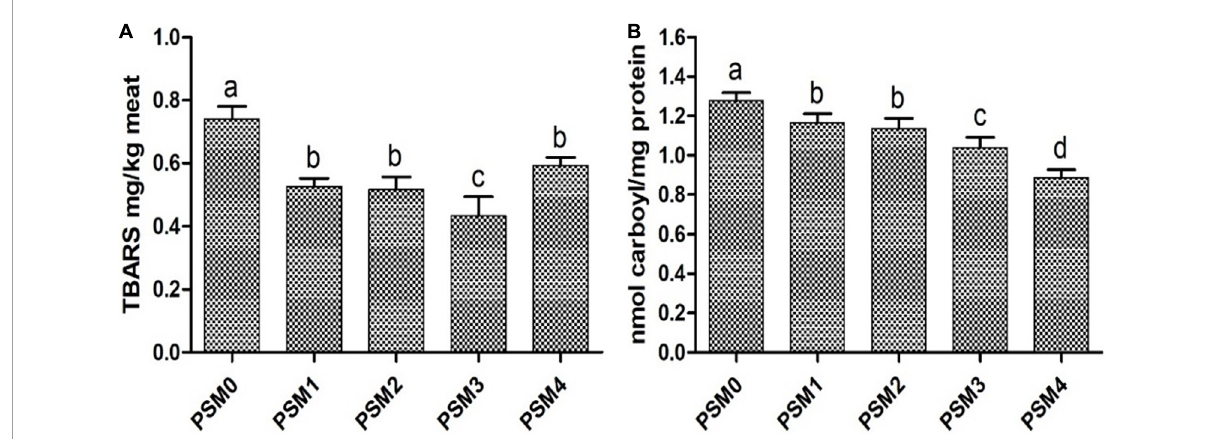
FIGURE1 TBARS (A) and carbonyl (B) content of pan-fried chicken patties formulated with various levels of Perilla seed meal (PSM) as a fat substitute ( P < 0.05). PSM 0% + fat 20% (PSM0), PSM 5% + fat 15% (PSM1), PSM 10% + fat 10% (PSM2), PSM 15% + fat 5% (PSM3), and PSM 20% + fat 0% (PSM4). Different letters above the bars indicate significant difference at P <